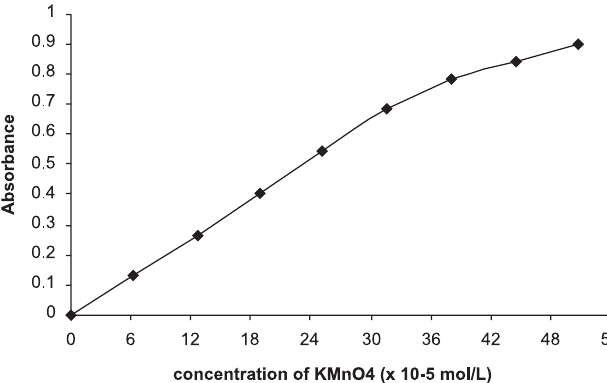
FIGURE 6 - Effect of reaction time between KMnO in method A and method B.